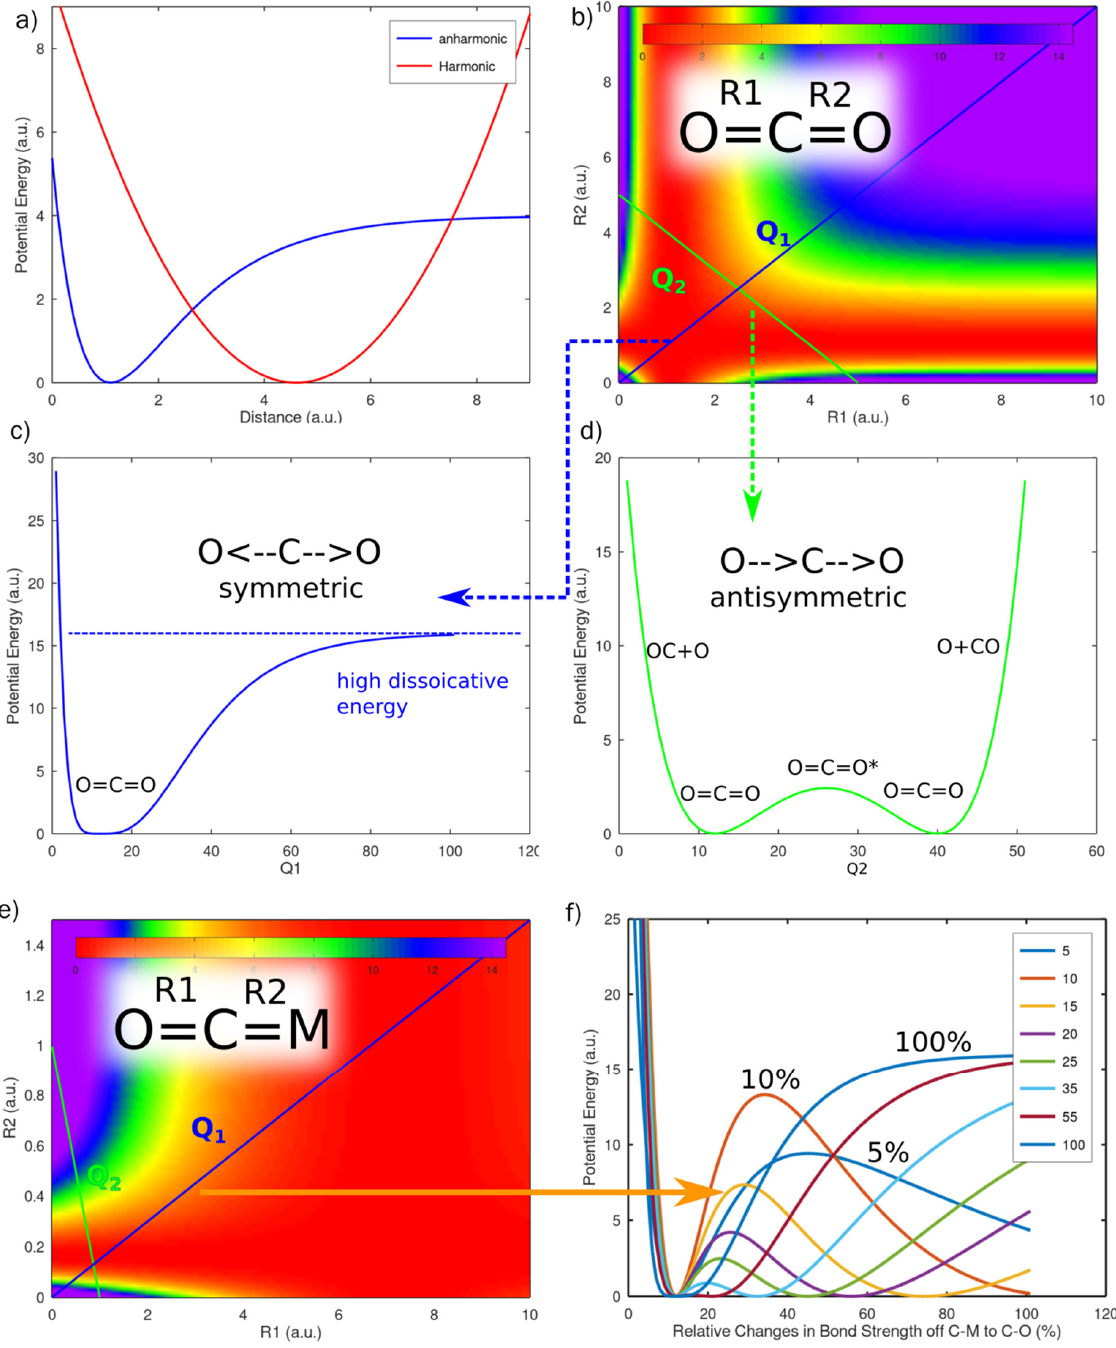
Figure 3. ( a ) Illustration for harmonic and anharmonic oscillation. ( b ) false-2D plot for the inter- nuclear changes of CO 2 molecules. ( c ) 1D plot for Q 1 coordinate from ( b ) showing anharmonic behavior. ( d ) 1D plot for Q 2 coordinate from ( b ), showing harmonic behavior. ( e ) false-2D plot for the internuclear changes of replacing one oxygen atom by a “Metal” atom that oscillates of 15% as the oscillation between the C and O atoms. ( f ) Various shapes for PE surfaces upon varying the oscillation of C-M bond relative to the C-O